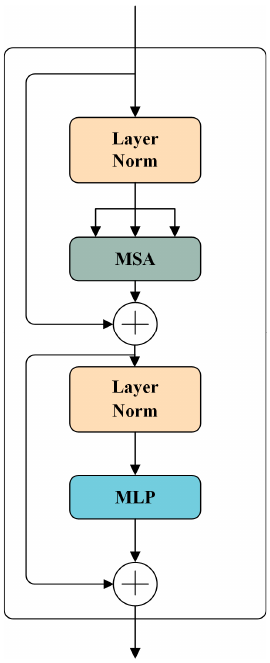
Figure 8. TransUnet’s transformer layer